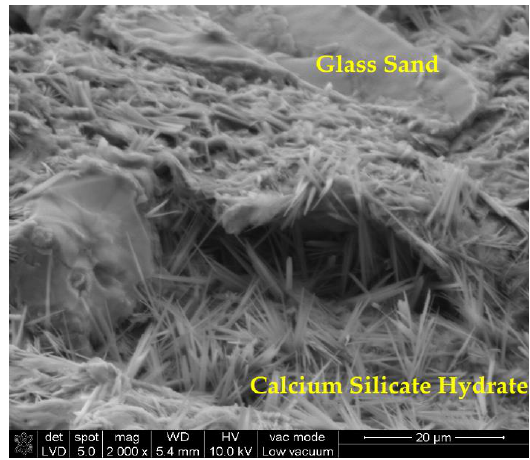
Figure 19. SEM image of “Glass Bricks” — brick modified by 90% GS, high-vacuum mode 2000× mag.